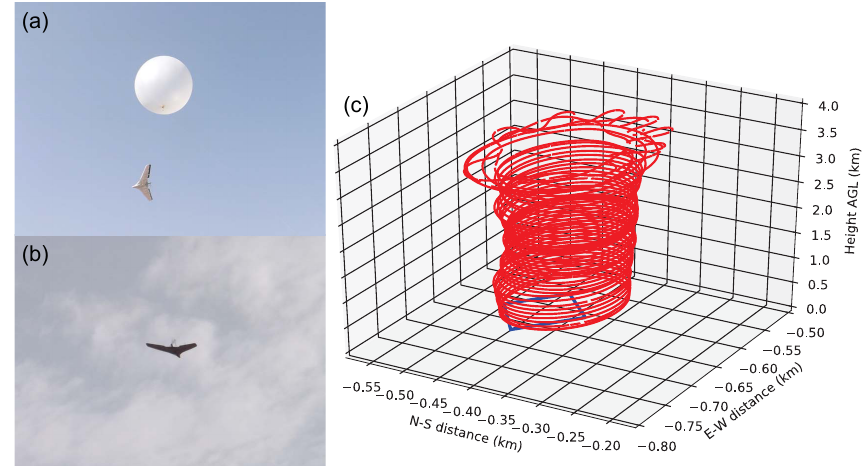
Figure 2. (a) Balloon lifting the DataHawk for the afternoon data set on 10 July 2014. (b) DataHawk flying towards the landing site for the same data set at an approximate altitude of 50m. (c) Helical trajectory of the DataHawk descending from approximately 3.75km to 500m over the SOUSY radar (indicated in blue). Table 2. DataHawk sensing system characteristics and capabilities (extracted from Lawrence and Balsley, 2013a). Value Value Wingspan 1m Alt. (balloon drop) > 9kmm.s.l. 0.7kg > 2kma.g.l.